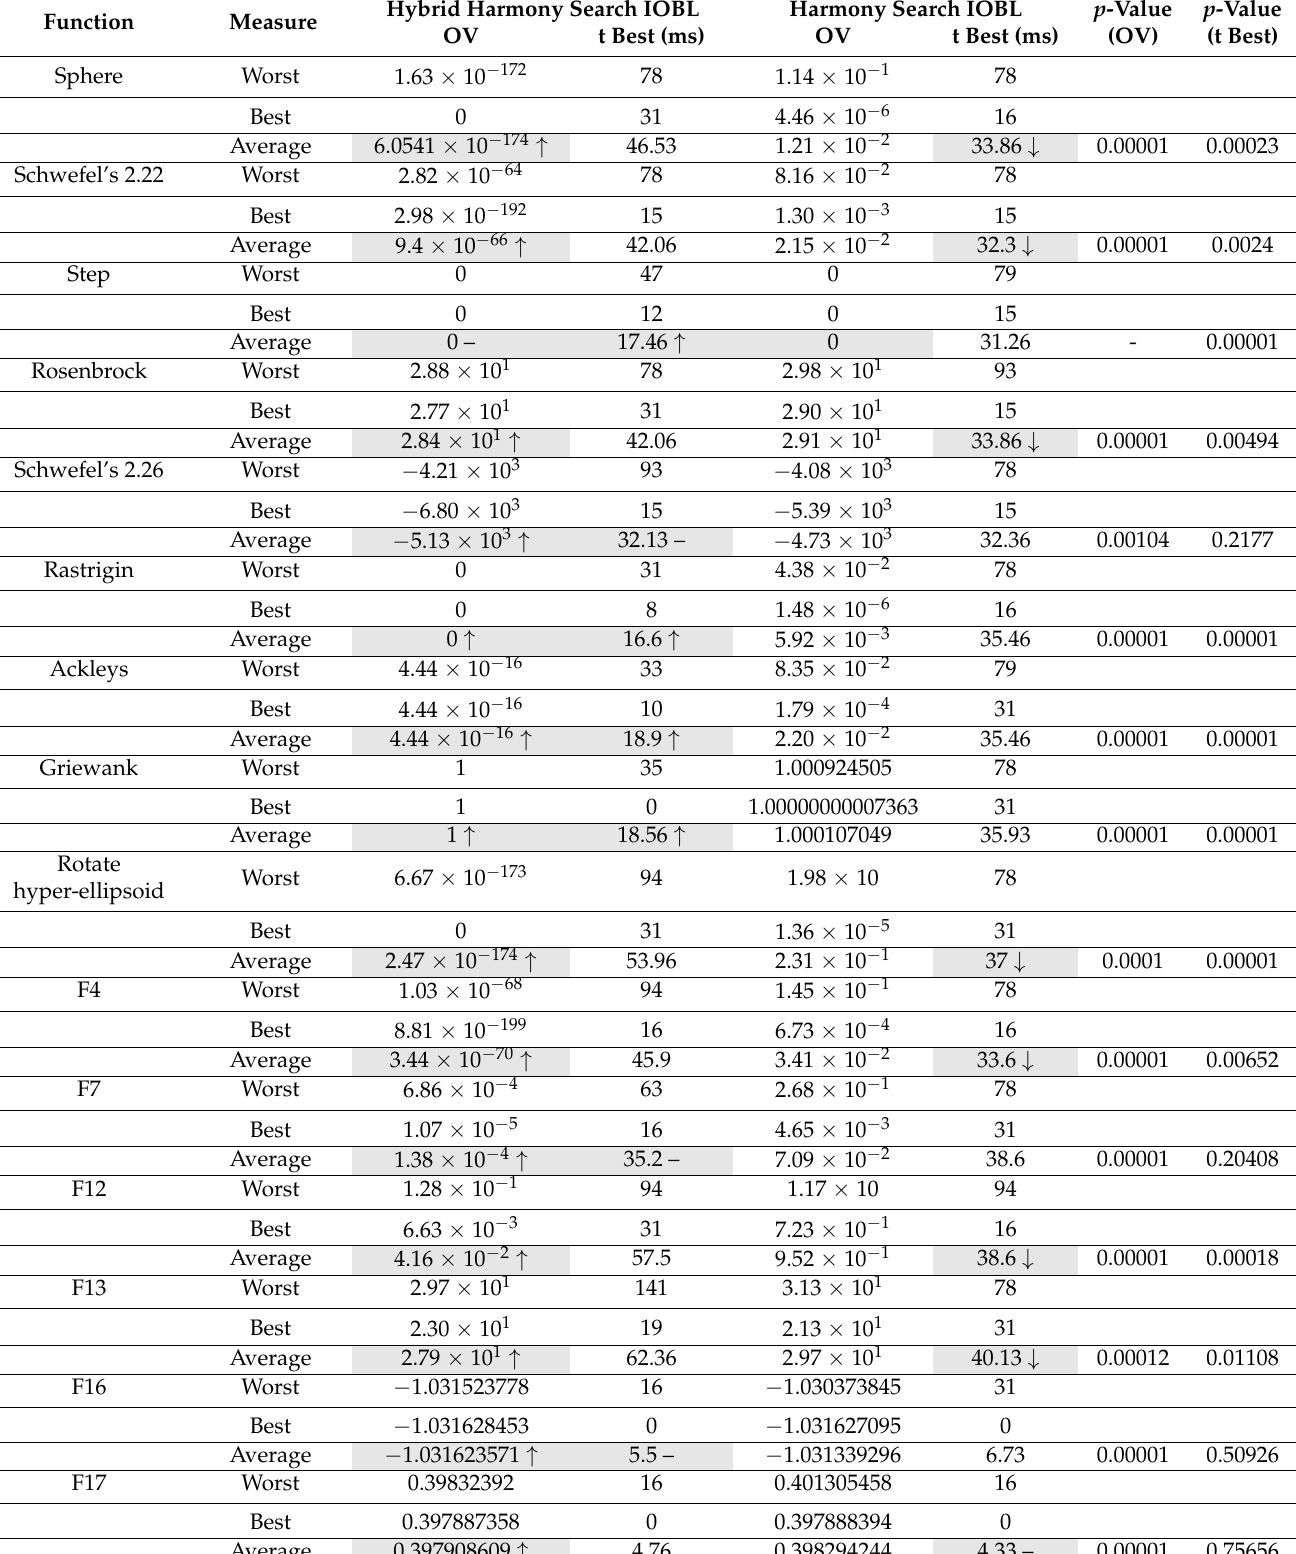
Table 3. Results obtained with the HHS-IOBL and HS-IOBL